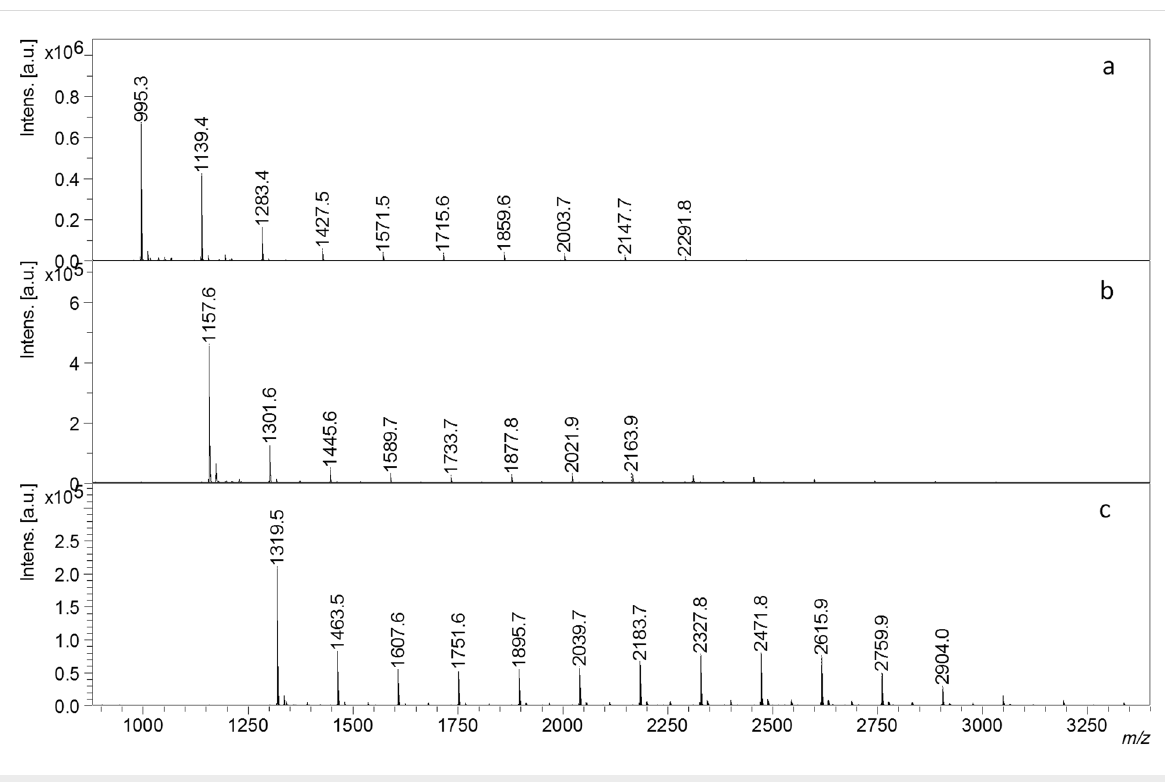
around 3.5 which is clearly lower than in the case of CD-LA products described